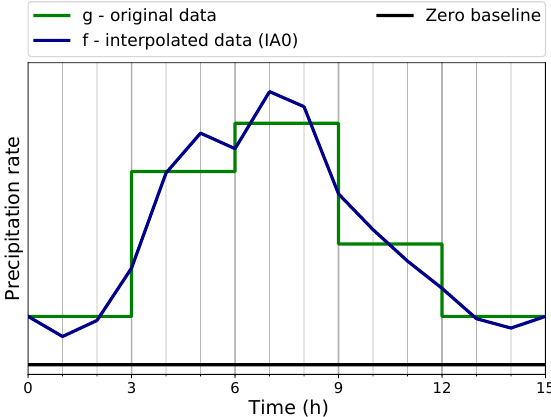
Figure 7. Results with the IA0 algorithm. The original precipita- tion rate g is shown in green with a 3-hourly resolution. The IA0 interpolated data f on the new sub-grid with 1-hourly resolution is given in dark blue. A zero baseline is shown in black.